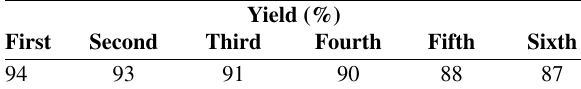
@ SiO O -NH 3 4 2 2